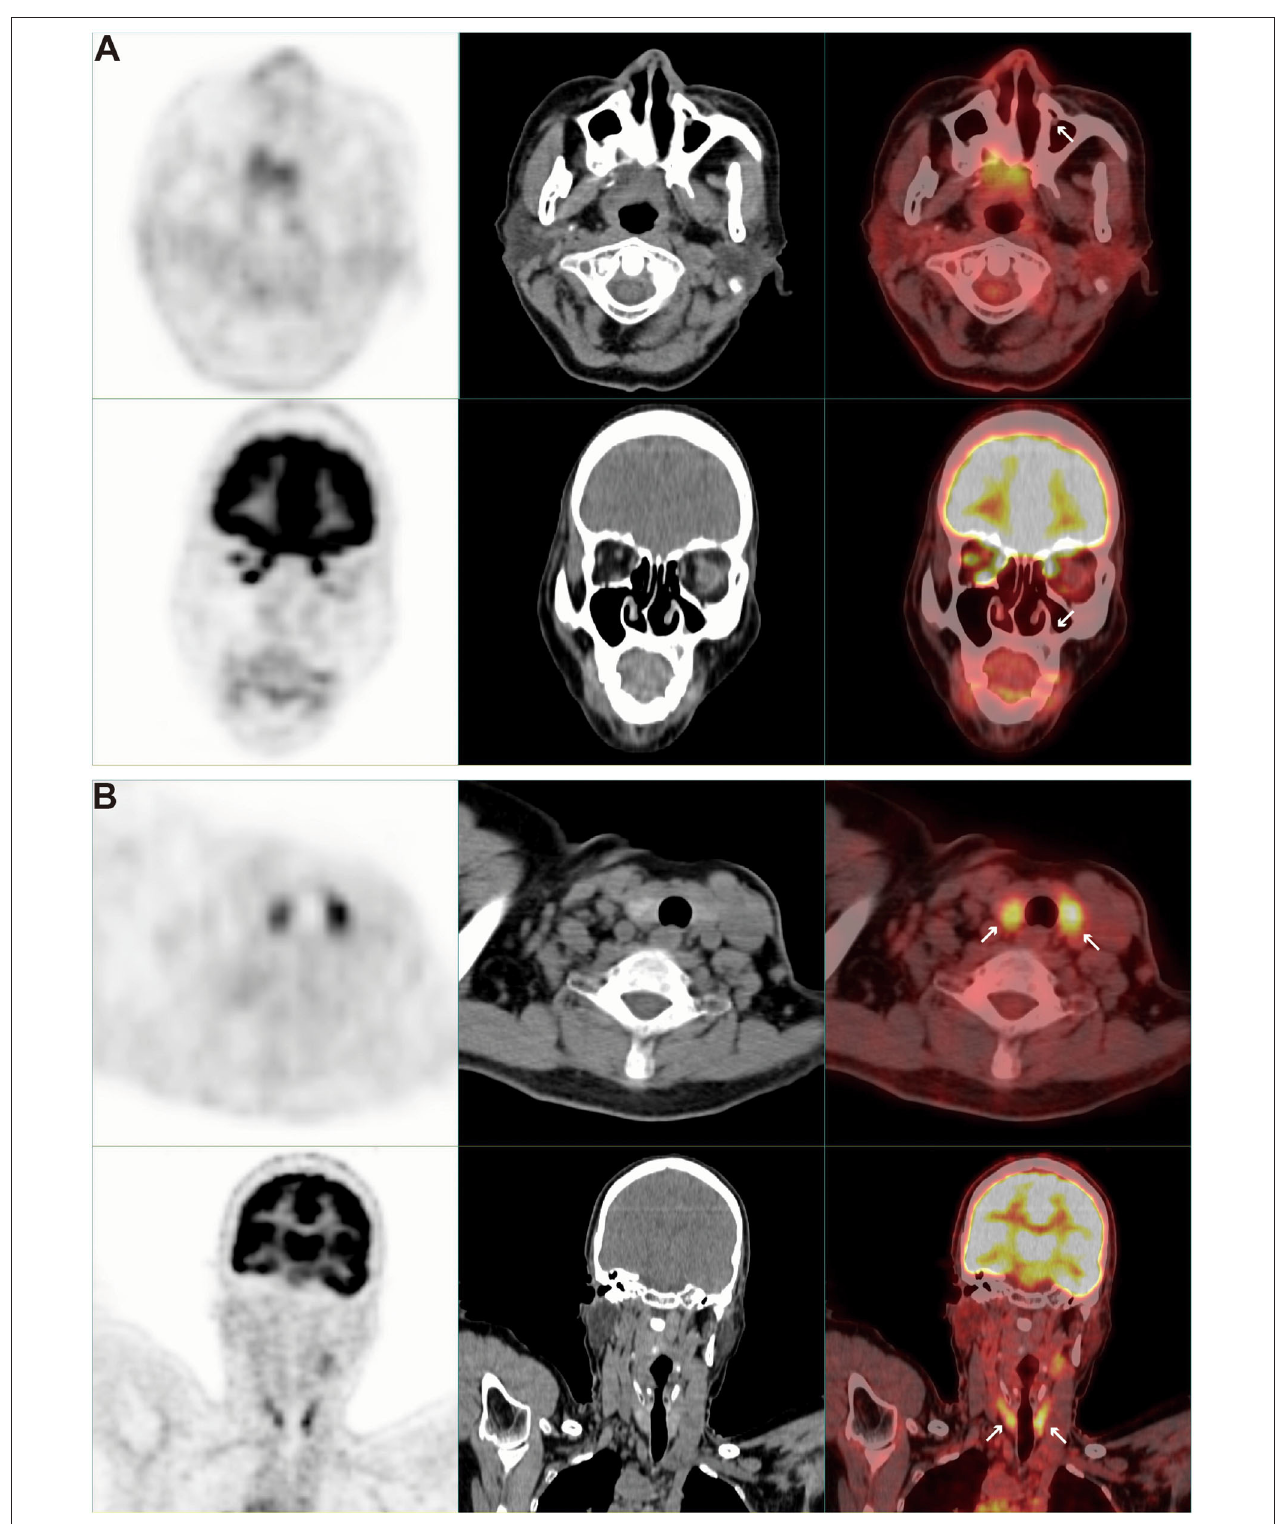
FIGURE 4 | PET / CT scan showed abnormalities of maxillary sinus and thyroid. (A) Axial and coronal PET, CT, and PET/CT fusion images show mucinous changes in the left maxillary sinus. (B) Axial and coronal PET, CT, and PET/CT fusion images showed abnormal tracer uptake in the patient’s thyroid.